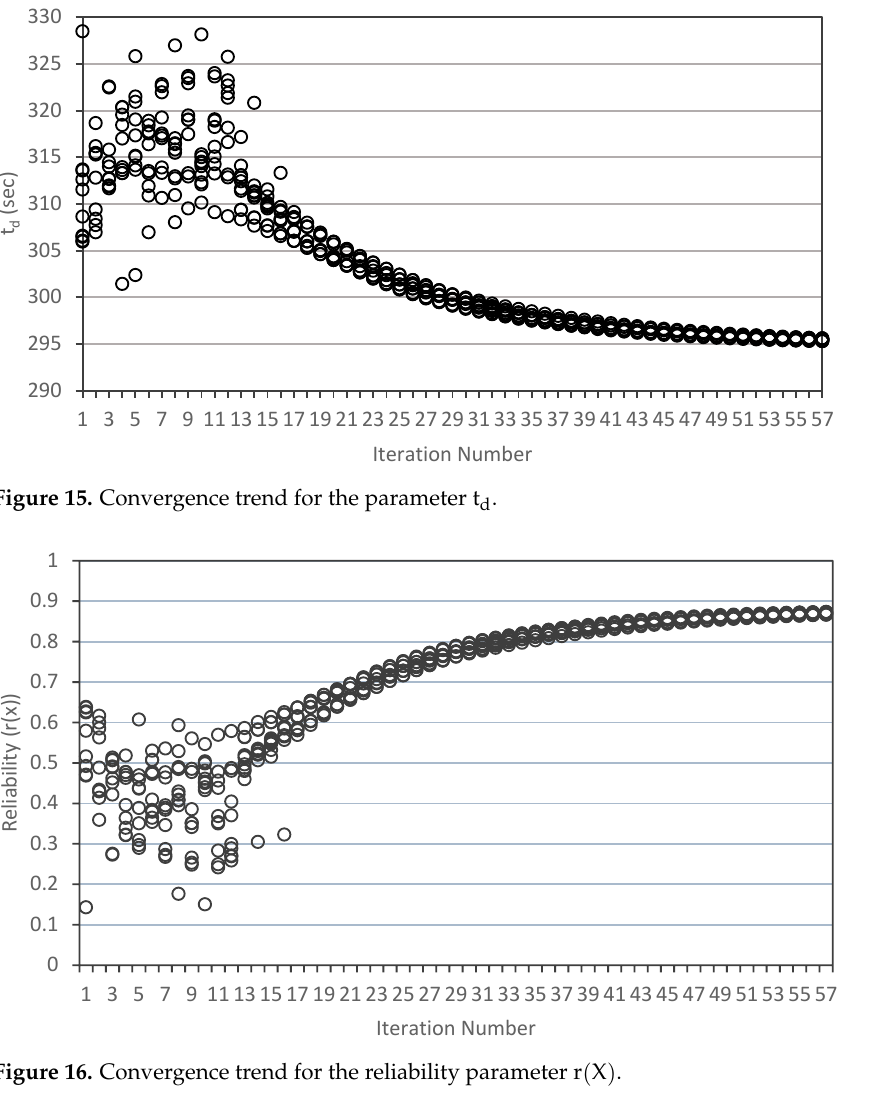
Figure 14. Objective function convergence trend for the optimal solution.